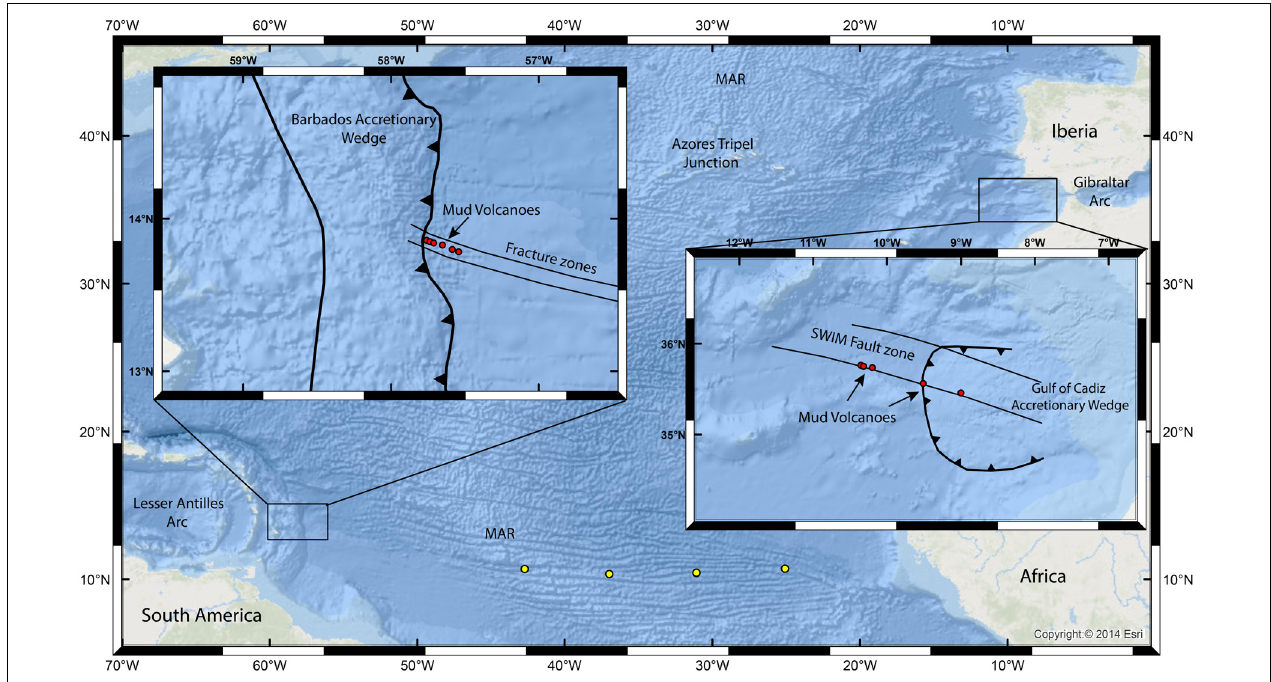
FIGURE 9 | Mud volcanoes related to active strike-slip faulting in the western Gulf of Cadiz and aligned along the Mercurus Fracture zone offshore Barbados [adapted from Godón et al. (2004); Hensen et al. (2015)]. Yellow dots along the Vema TFFZ indicate the location of gravity cores shown in Figure 8 (bathymetric map was created using ArcGIS R (cid:13) software by Esri